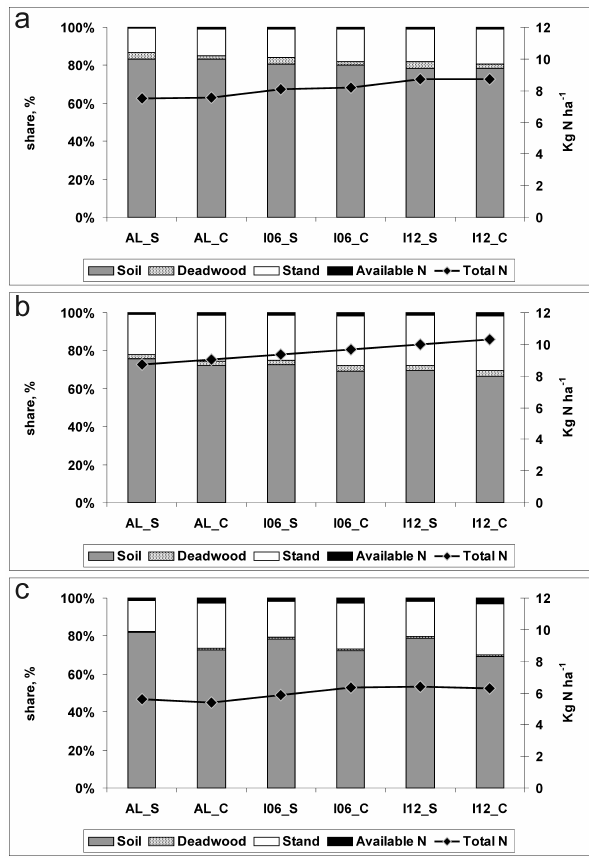
Fig. 4. Proportions of different SOM fractions and total car- bon stock in soil by the end of simulation with different lev- els of nitrogen deposition (AL – ambient level, I06 – increase of 6kg[N]ha − 1 yr − 1 , I12 – increase of 12kg[N]ha − 1 yr − 1 ) and cli- the different areas under study ( (a) – Dankovskoe forest area, (b) –